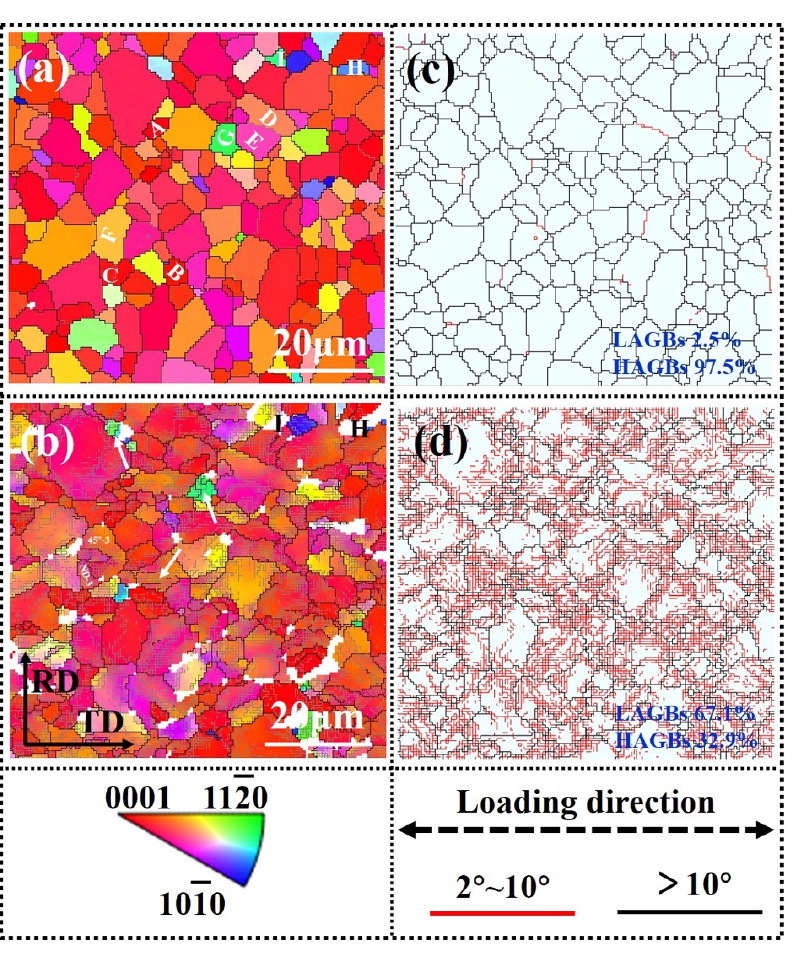
Figure 5. The IPF colored and grain boundary map of Zircaloy-4 after tensile test along TD at different strains, ( a , c ) 0.00%, ( b , d ) 6.20%.